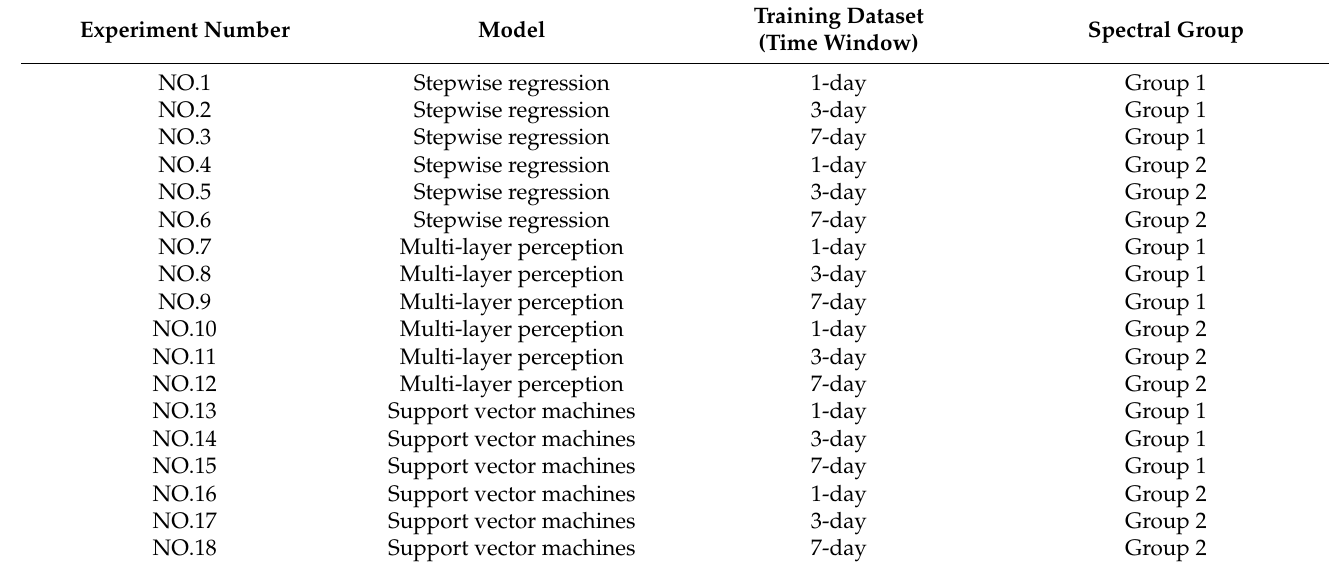
Table 3. The experiments conducted in this study and their relevant details. Group 1 represents the spectral variables that use a single band or band combination. Group 2 represents the spectral variables that use band combination and band ratio.